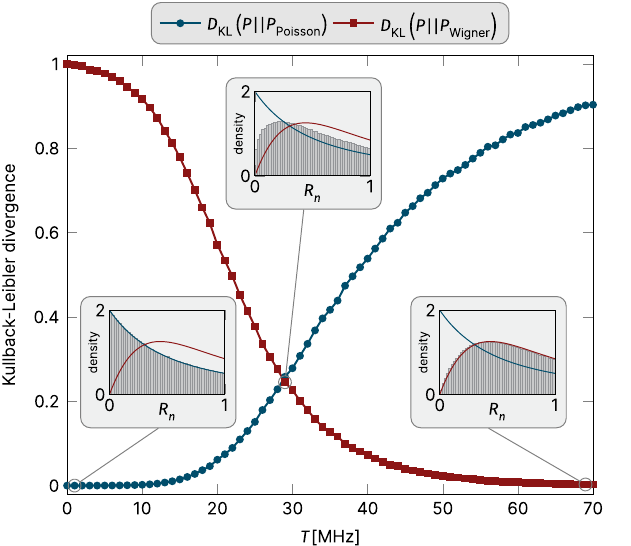
Fig. 3 Spectral statistics. Shown are data for a chain of N = 10 transmons versus the coupling parameter T . The average Josephson energy is fi xed to E J = 44 GHz, and scheme- A disorder is used ( δ E J = 1.17 GHz). These statistics indicate a transition from Poisson statistics (blue) in the MBL regime (at low coupling) to Wigner – Dyson statistics (red) in a many-body delocalized regime (at large coupling). Shown are normalized Kullback – Leibler (KL) divergences D KL (see Eq. (7) in Methods) calculated for the distribution of ratios of consecutive level spacings R n in the energy spectrum, such as the ones illustrated in the insets for three characteristic couplings. The KL divergences are normalized such that (cid:3) (cid:4) D P P ¼ 1 and vice versa. All results are averaged over at KL Wigner k Poisson least 2500 disorder realizations.